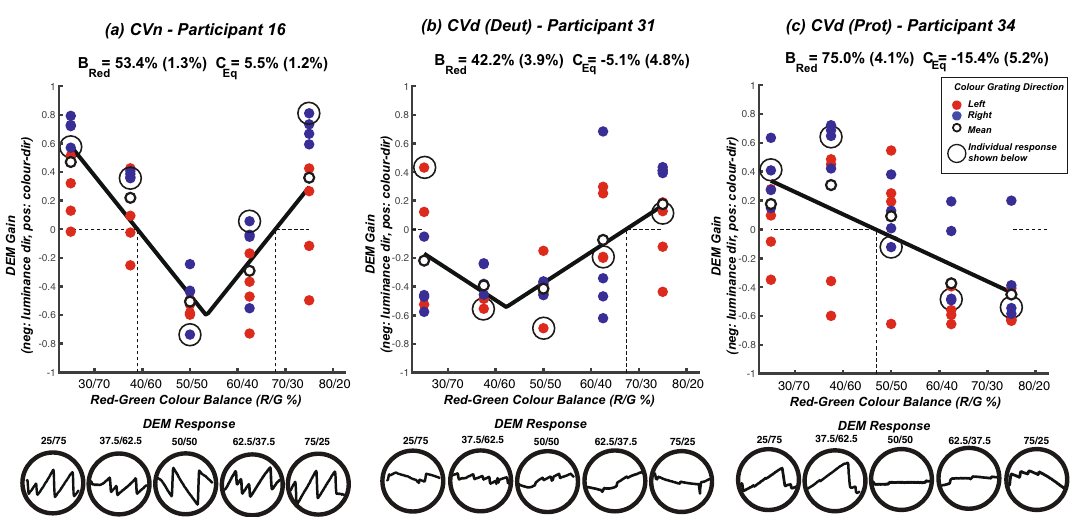
B = 42.2% (3.9%) C = -5.1% (4.8%) Red